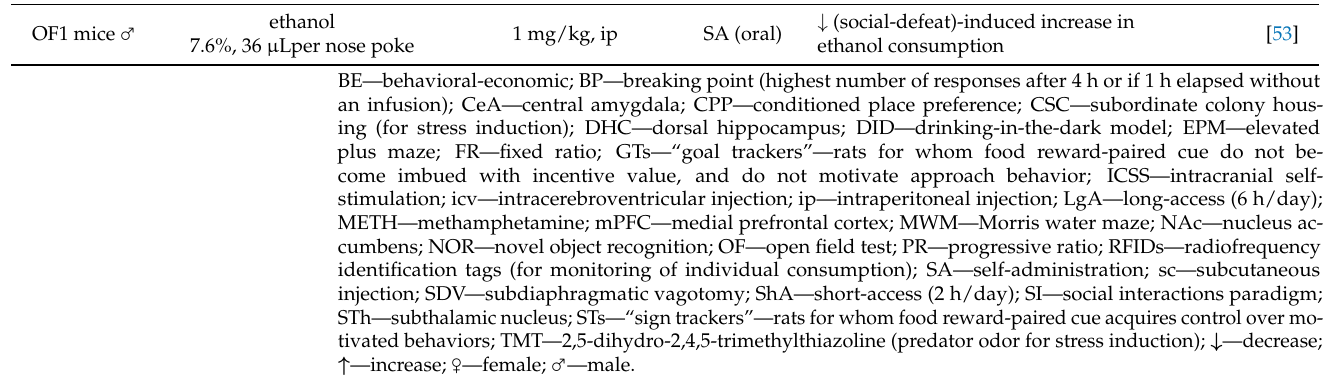
Table 2. The effects of OTRs ligands on behavioral/rewarding effects of different drugs of